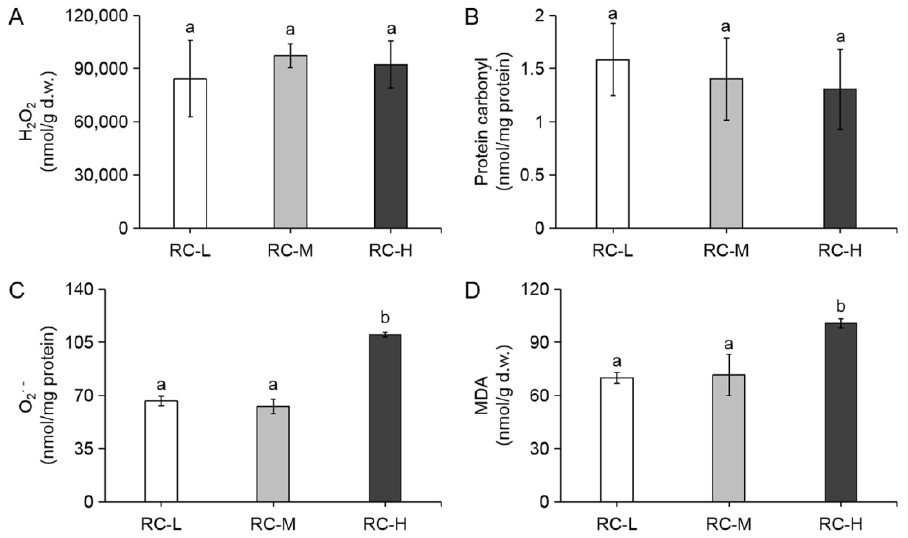
Figure 1. Oxidative states in rhizomes of Rhodiola crenulata (RC-L, RC-M, and RC-H) from different altitudes (3933, 4249 and 4531 m), respectively. ( A ): H 2 O 2 ; ( B ): Protein carbonyl; ( C ): O 2·− ; ( D ): Malondialdehyde (MDA). Results are presented as the mean ± SD of six independent experiments ( n = 6). In each column, different letters (a, b) mean significant differences between two groups ( p < 0.05) found via a t -test. Note: Rhodiola crenulata samples are presented according to the ascending order of altitude from left to right.